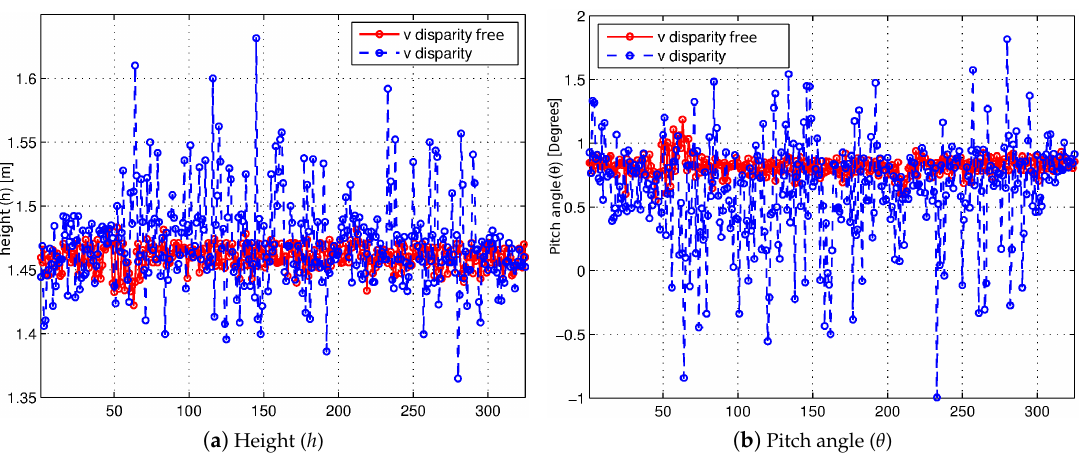
Figure 4. Evolution of estimated extrinsic parameters ( h , θ ) along the synthetic sequence [10] using the v-disparity (blue) and the v-disparity-free (red), respectively.